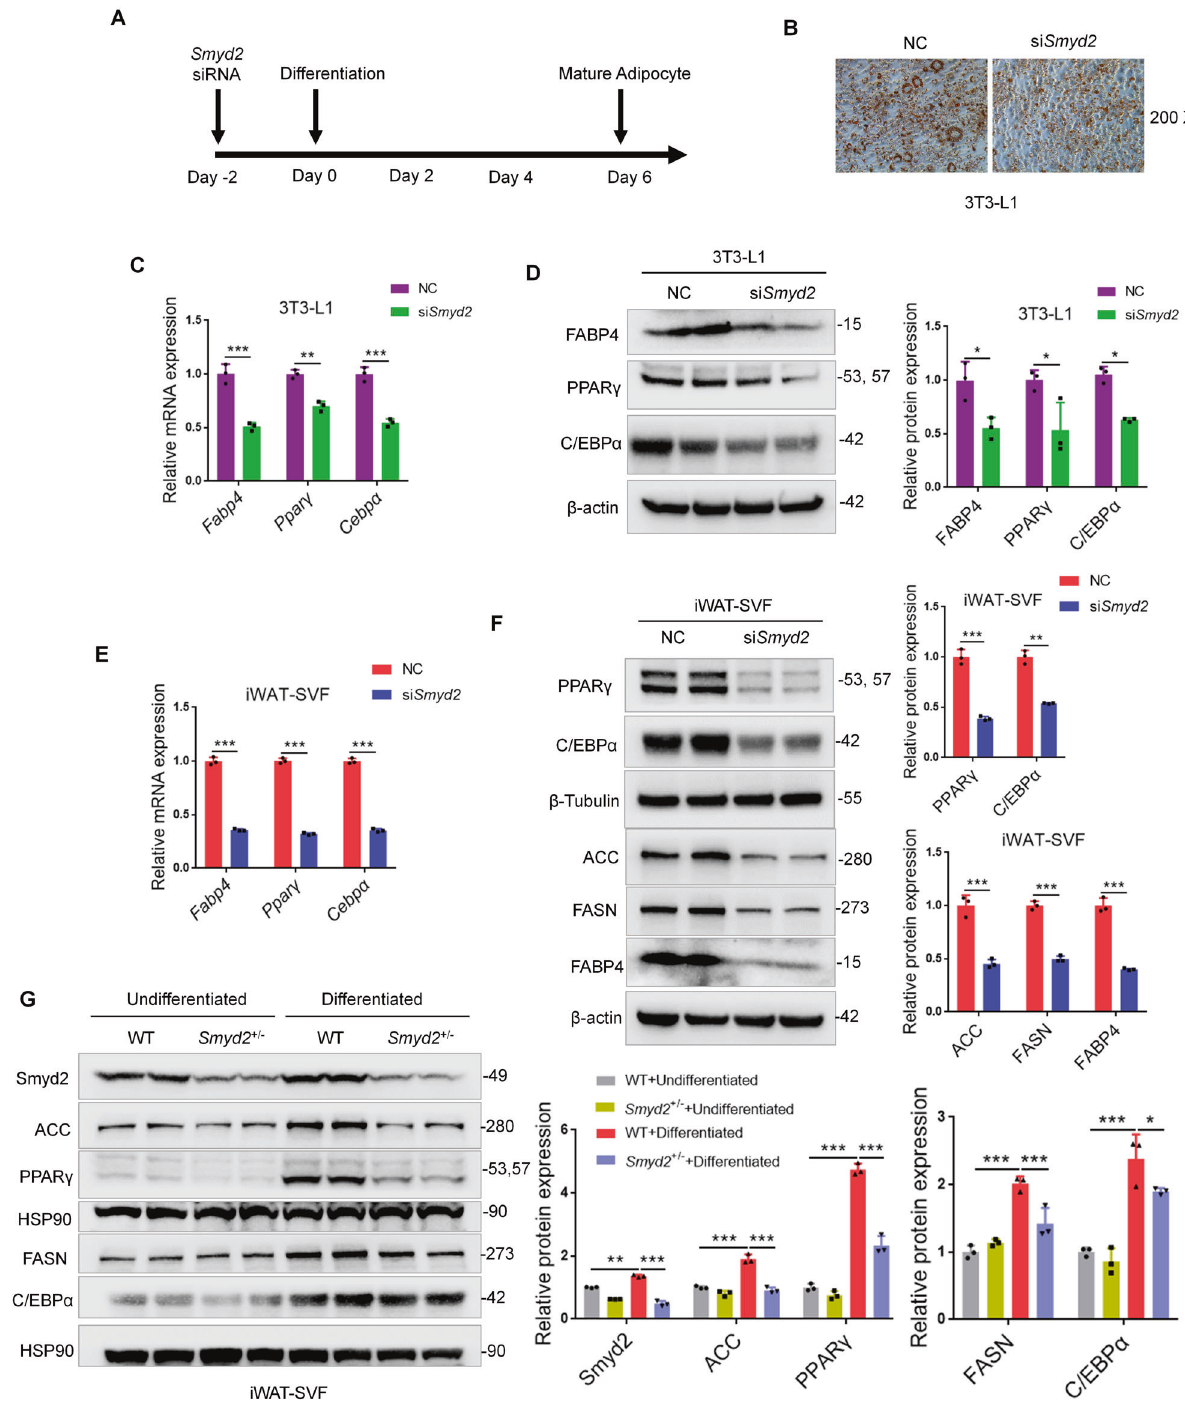
Fig. 3 Knockdown of Smyd2 inhibits adipocyte differentiation in vitro. 3T3-L1 preadipocytes or iWAT-SVF were transfected with Smyd2 siRNA or NC, followed by differentiation as described in the methods section. A The work fl ow for Smyd2 siRNA transfection and adipocyte differentiation. B The Oil Red O staining of 3T3-L1 adipocytes with NC or Smyd2 siRNA transfection. Magni fi cation × 200. C The mRNA levels of adipogenesis markers ( Ppar γ , Cepb α , and Fabp4 ) of 3T3-L1 adipocytes with NC or Smyd2 siRNA transfection. D The protein expressions of adipogenesis markers (PPAR γ , C/EBP α and FABP4) of 3T3-L1 adipocytes with NC or Smyd2 siRNA transfection. E The mRNA levels of adipogenesis markers ( Ppar γ , Cepb α , and Fabp4 ) of iWAT-SVF adipocytes with NC or Smyd2 siRNA transfection. F The protein expressions of adipogenesis markers (PPAR γ , C/EBP α , FABP4), the rate-limiting enzyme in adipogenesis (ACC and FASN) of iWAT-SVF adipocytes with NC or Smyd2 siRNA transfection. G The primary iWAT-SVF from WT and Smyd2 + / − mice were isolated and induced to undifferentiation or differentiation. Expression of Smyd2, adipogenesis markers (PPAR γ , C/EBP α ) and the rate-limiting enzymes in adipogenesis (ACC and FASN) were examined by western blot. Data are presented as mean ± SD. * p < 0.05, ** p < 0.01, *** p < 0.001.